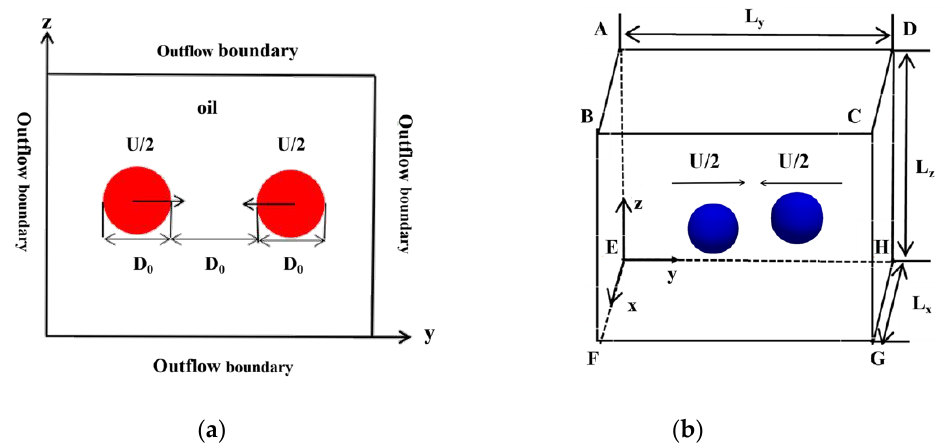
Figure 1. Schematic diagram of the collision calculation domain and initial state of binary equal-sized droplets: ( a ) schematic of the binary droplets center collision; ( b ) schematic of the off-center collision computational domain.